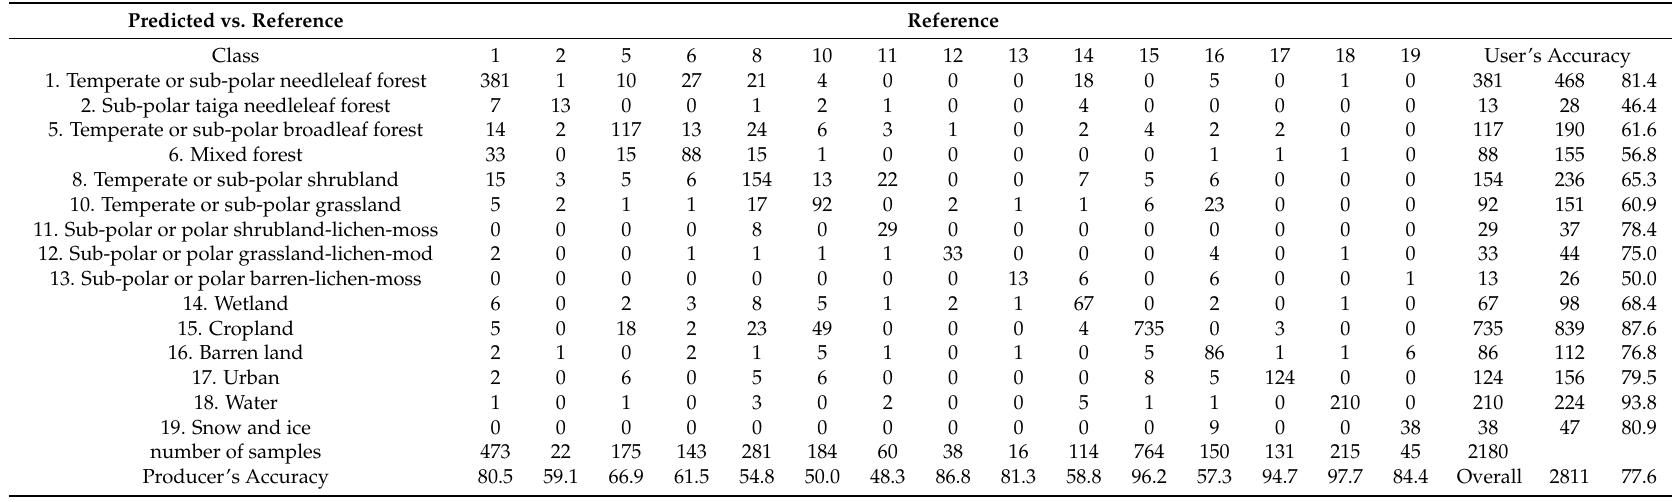
Table 6. Error matrix for the Land Cover Map of Canada 2010 with agreement defined as a match between the map label and the primary reference label. Rows of the error matrix are the map classes, and columns are the reference classes. Predicted vs.